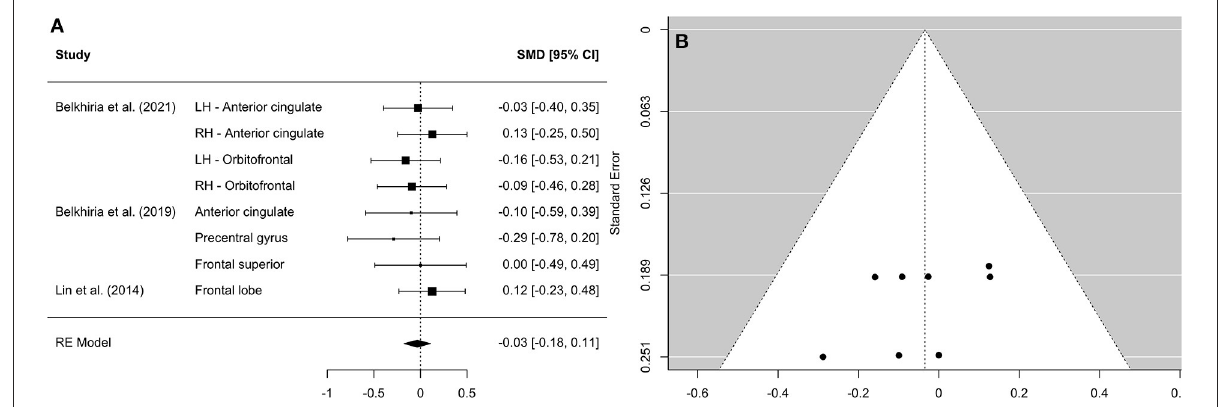
FIGURE4 Forest plot (A) and funnel plot (B) of the frontal lobe analysis. In the forest plot (A) negative values on the x-axis indicate gray matter atrophy.